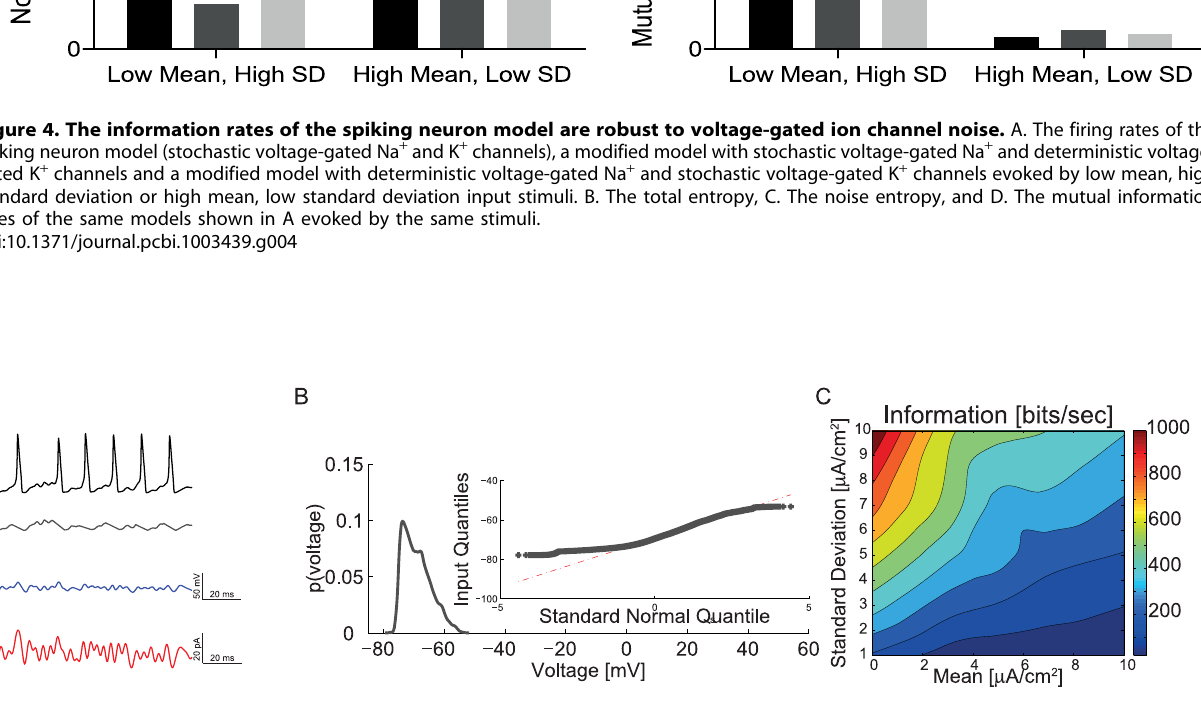
Figure 5. The information encoded in the pseudo-generator potentials of the spiking neuron model. A. Action potentials (top black trace) evoked by white noise current stimuli (bottom red trace). Upper grey trace: The same voltage response with the action potentials removed and replaced with a linear interpolation of the voltage. This is the pseudo-generator potential, which is an approximation of the generator potential. Lower blue trace: A voltage response of the graded neuron model to the current stimulus shown in the bottom trace. B. The PDF of the pseudo- generator voltage response. (Inset) A QQ plot showing departures from a Gaussian distribution (dotted red-line) for the time-series shown in A (upper grey trace). C. Information rates (bits s 2 1 ) of pseudo-generator potentials evoked by white noise current stimuli with different means and standard deviations. The stimuli are identical to those in Figures 2 and 3.